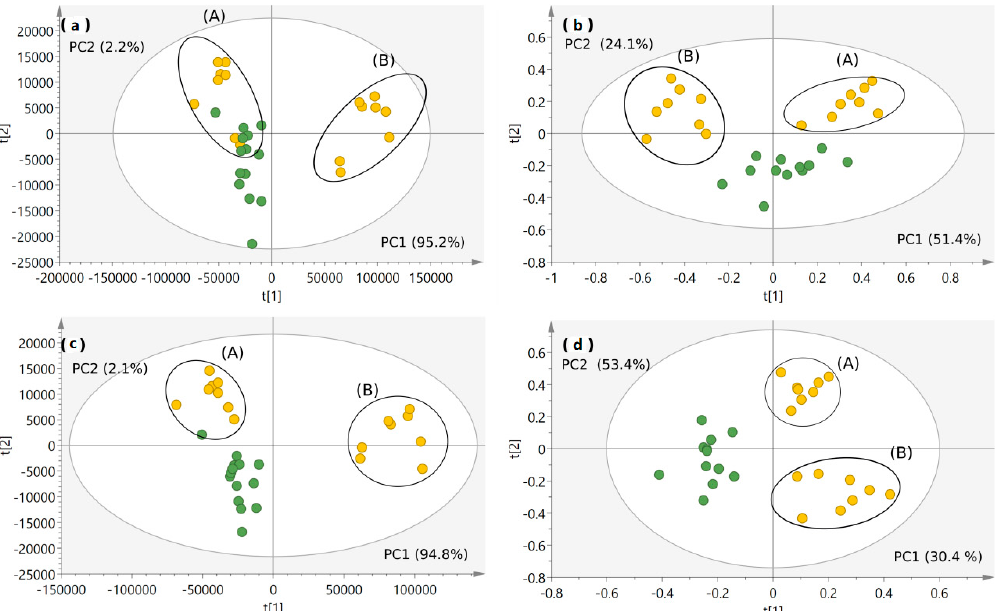
Figure 6. Score plots obtained after the PCA and PLS-DA analyses on the UNor and NorCont data of the lipid fraction of organic and conventional processed (P) milk samples. ( a ) PCA score plot of UNor procedure, ( b ) PLS-DA score plot of the NorCont procedure, ( c ) PCA score plot of the UNor procedure, ( d ) PLS-DA score plot of the NorCont procedure. Yellow circles for conventional and green circles for organic samples; (A), conventional milk samples consisted of 1.5% fat content and (B), conventional milk samples consisted of 3% fat content.